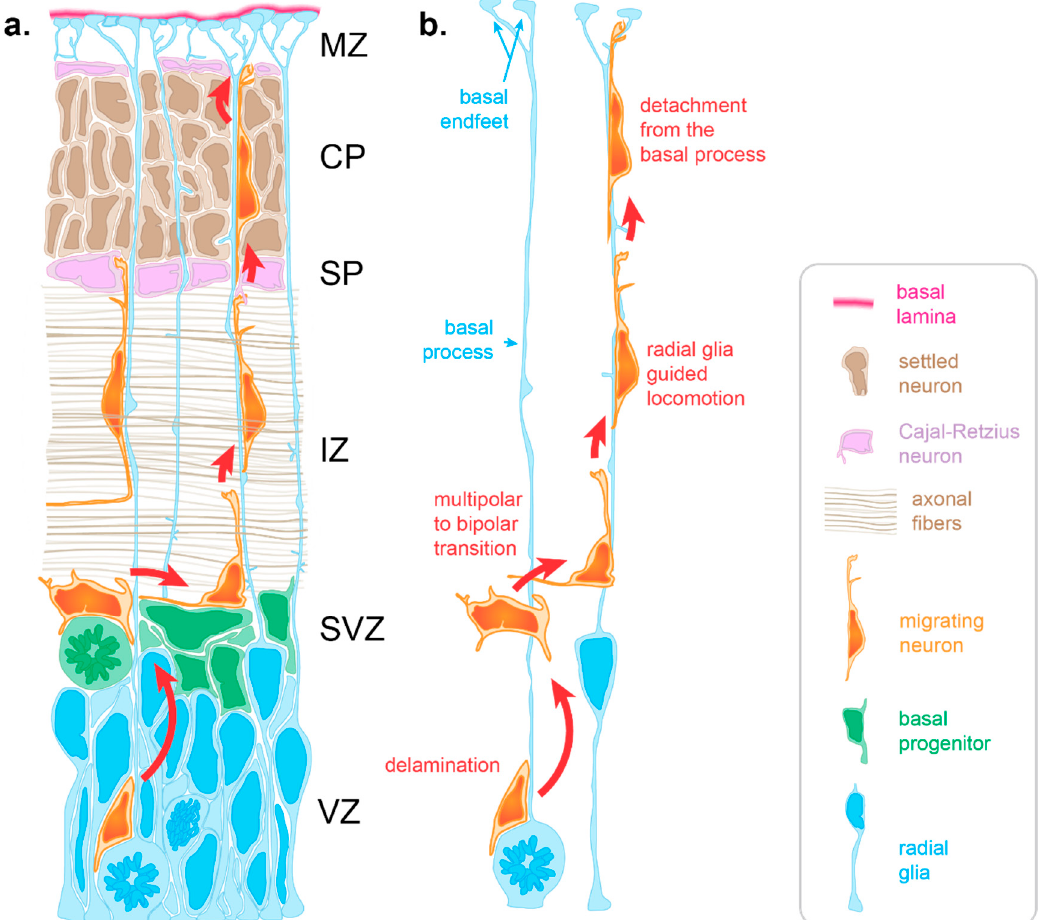
Figure 1. Radial migration in the developing cortex. ( a ) Radial migration relies on the radial glia basal process for guidance. Immature neurons born at the apical surface of the developing cortex use the basal process to navigate through varied and densely packed histological layers before resting in their final location within the cortical plate (CP). ( b ) Neuronal migration occurs in several key stages. Delamination from the ventricular zone (VZ) brings the newly differentiating neuron to the subventricular zone (SVZ), where it adopts a multipolar morphology allowing for brief tangential migration. Recognition of the radial glia basal process by the migrating neuron drives a transition to a bipolar morphology as basal process–neuron interactions enable radial glia to guide radial migration. Glia guided locomotion is necessary for the neuron to negotiate the compact layers of settled cortical neurons. Once the neuron is properly positioned, termination signaling leads to detachment from the basal process. (IZ: intermediate zone, SP: subplate, MZ: marginal zone).